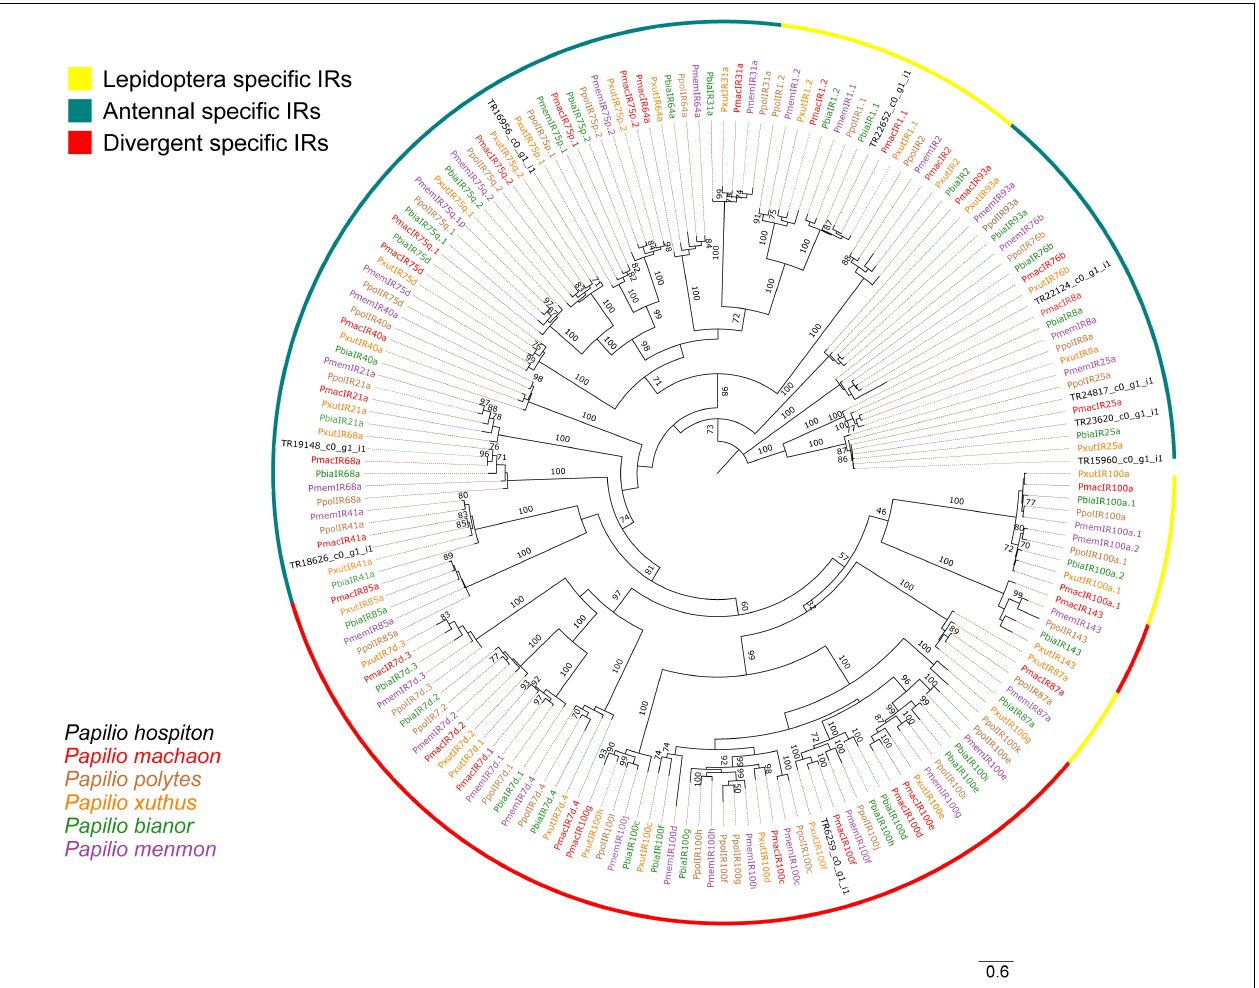
FIGURE 3 | Phylogeny of P. hospiton maxilla-expressed ionotropic receptors (IRs). A maximum-likelihood tree was built with IR repertoires annotated from genomic datasets of P. machaon , P. xuthus , and P. polytes (Liu et al., 2018), and P. memnon and P. bianor (Yin et al., 2021) using RAxML. The tree was re-rooted on IR8/IR25 clade. Branch lengths are scaled by the number of nucleotide substitutions per site. Bootstrap values refer to 500